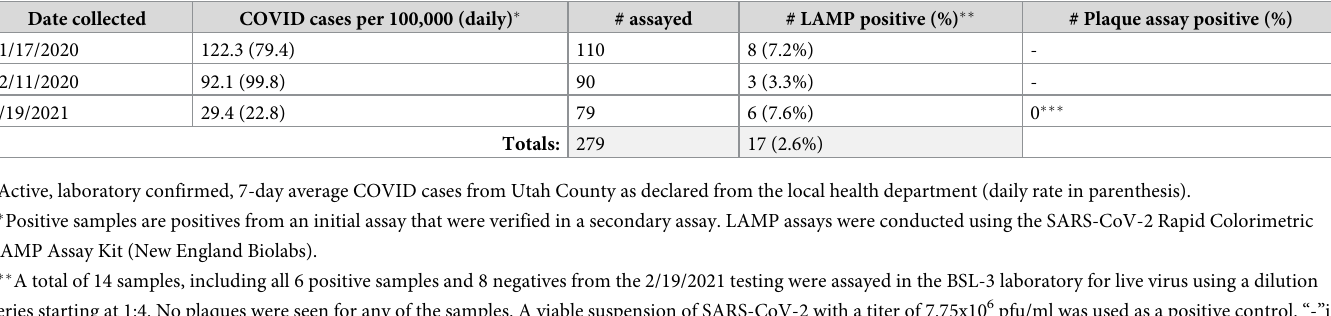
tested positive, consistent with the observed instability observed on banknotes (Table 3). Only